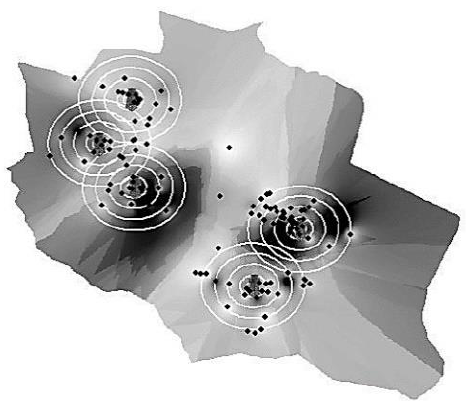
Figure 5. Distribution of volunteers ’ houses on the power density map.